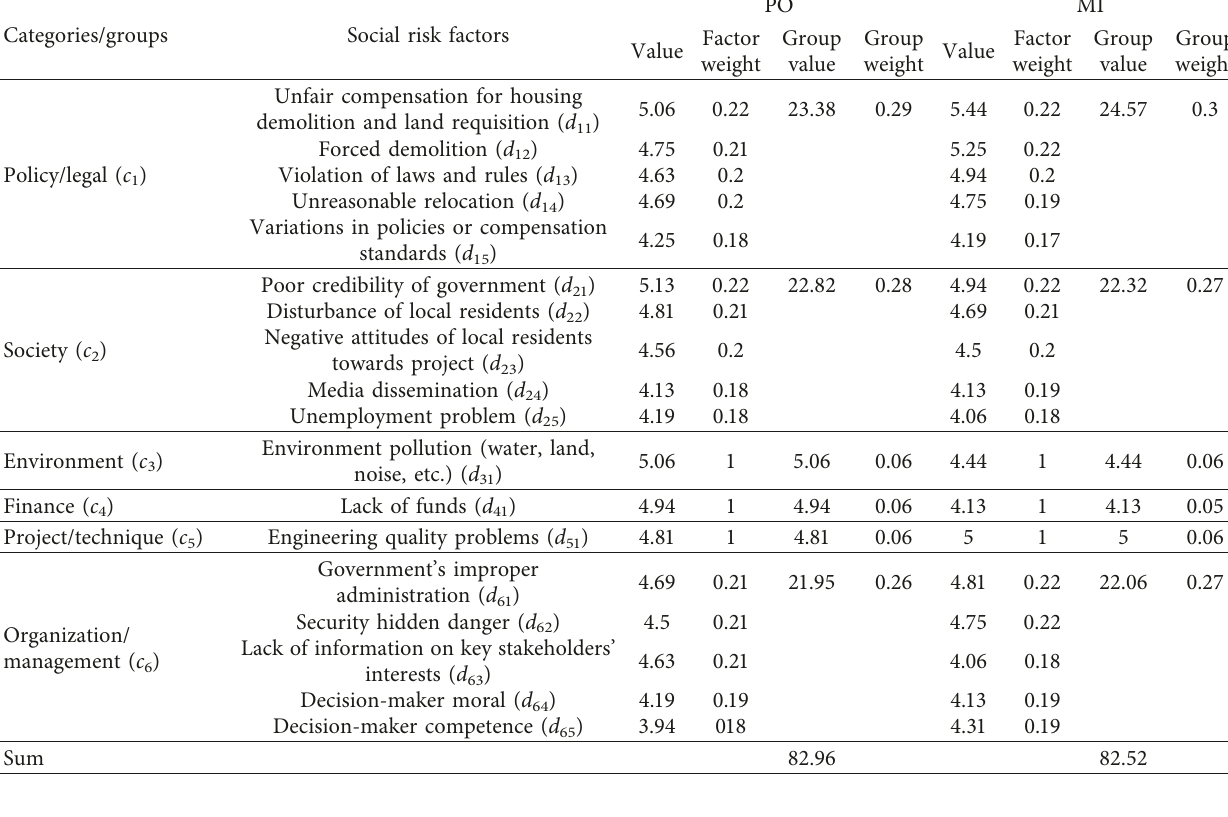
Table 5: Weight of CSRFs and